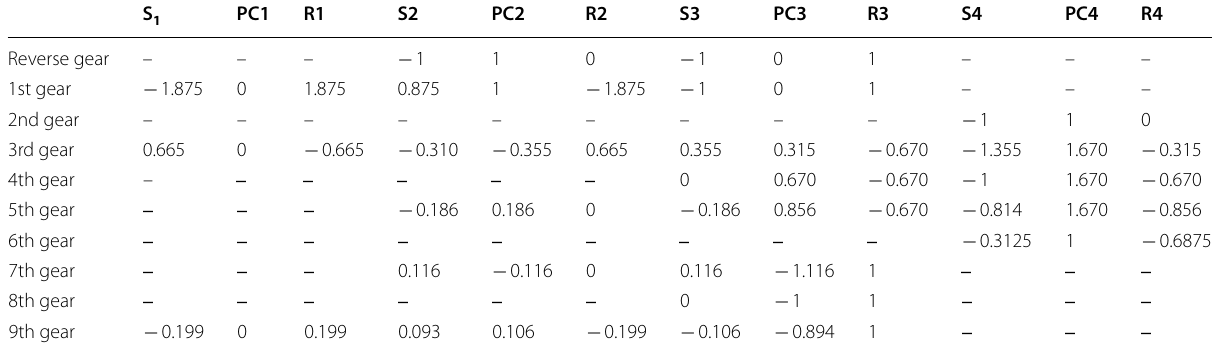
Table 6 Power passing through each member of the novel AT mechanism (1) (W)